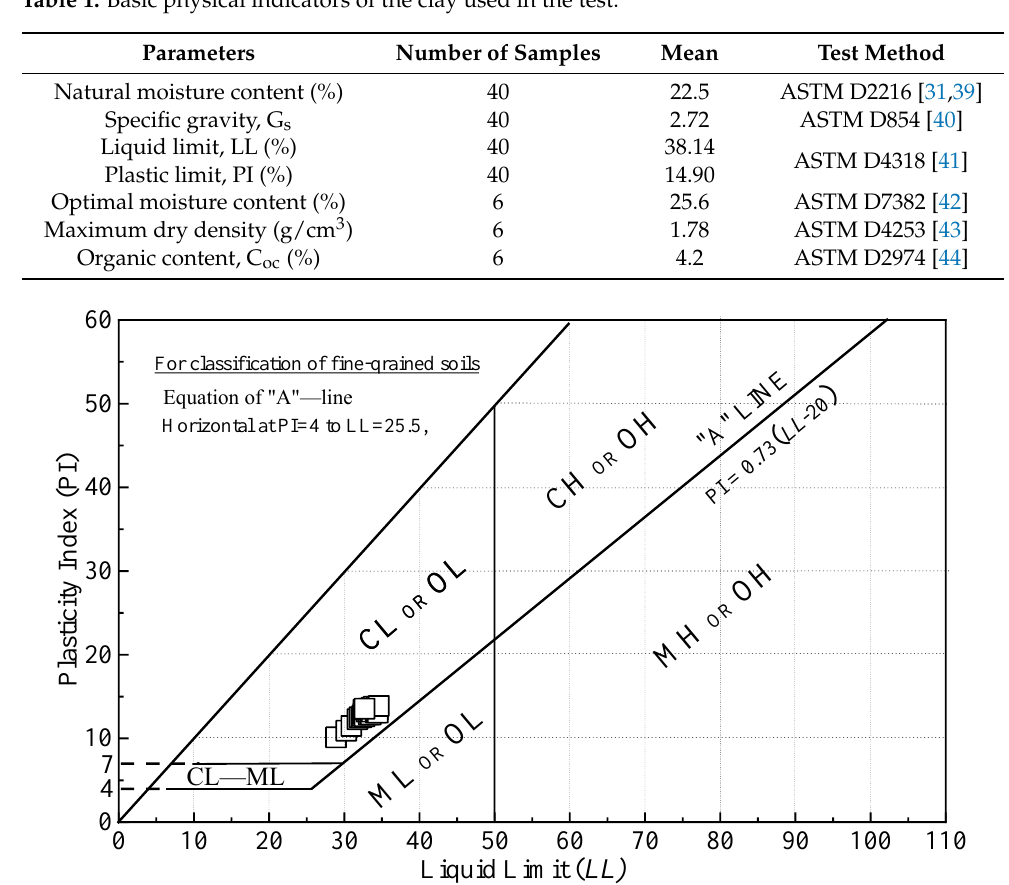
Table 1. Basic physical indicators of the clay used in the test.